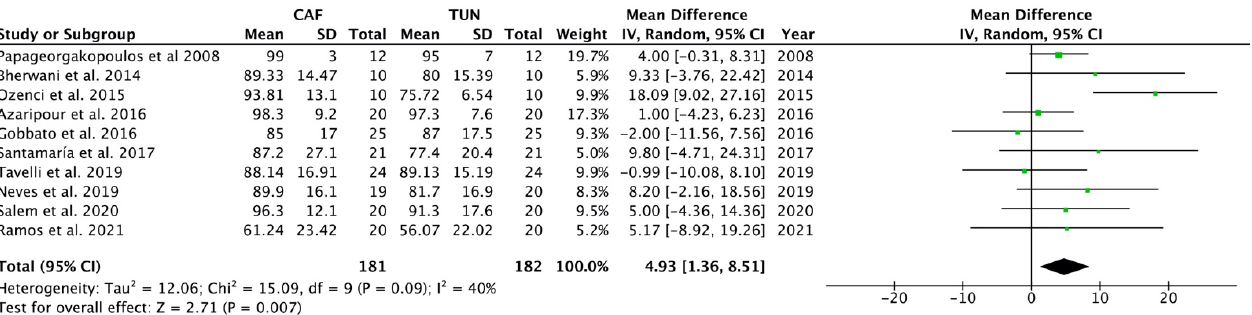
Figure 9. Forest plot for TUN (control group) versus CAF (test group) when comparing the percentage of root coverage after surgical treatment after excluding Tozüm et al. [41] from the analysis. The weighted means are presented with a CI of 95%. Heterogeneity was determined using Higgins (I 2 ). A random-effects model was applied to all analyses. Statistical significance was set at 0.05.